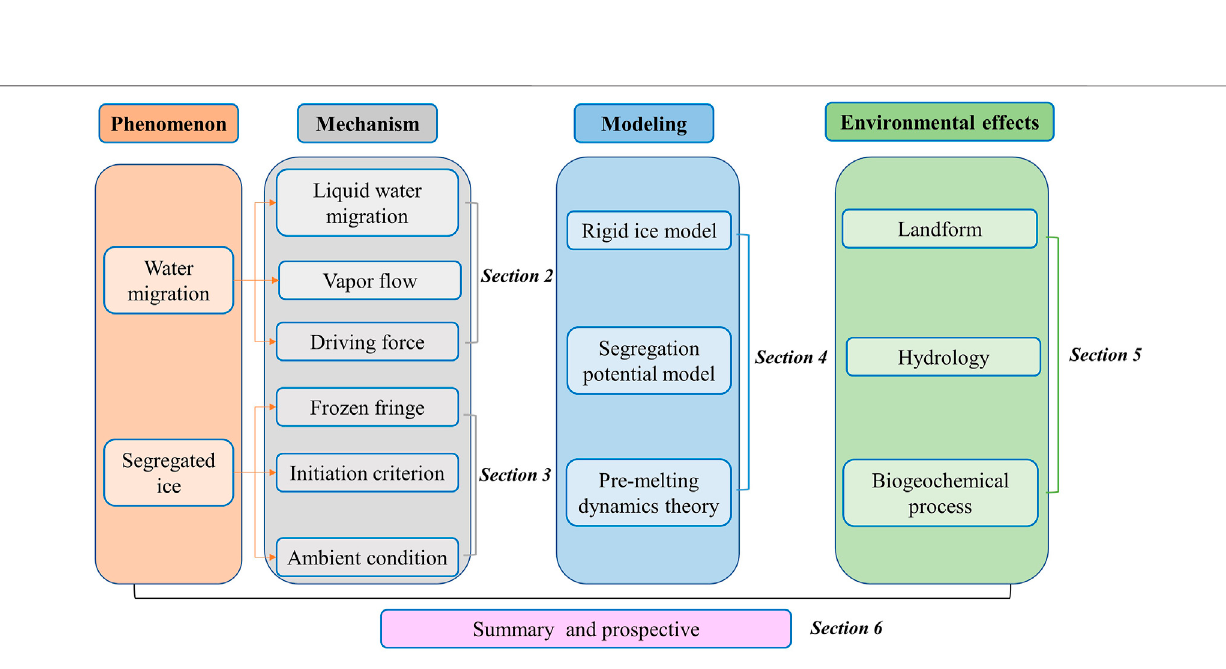
Frontiers in Earth Science |